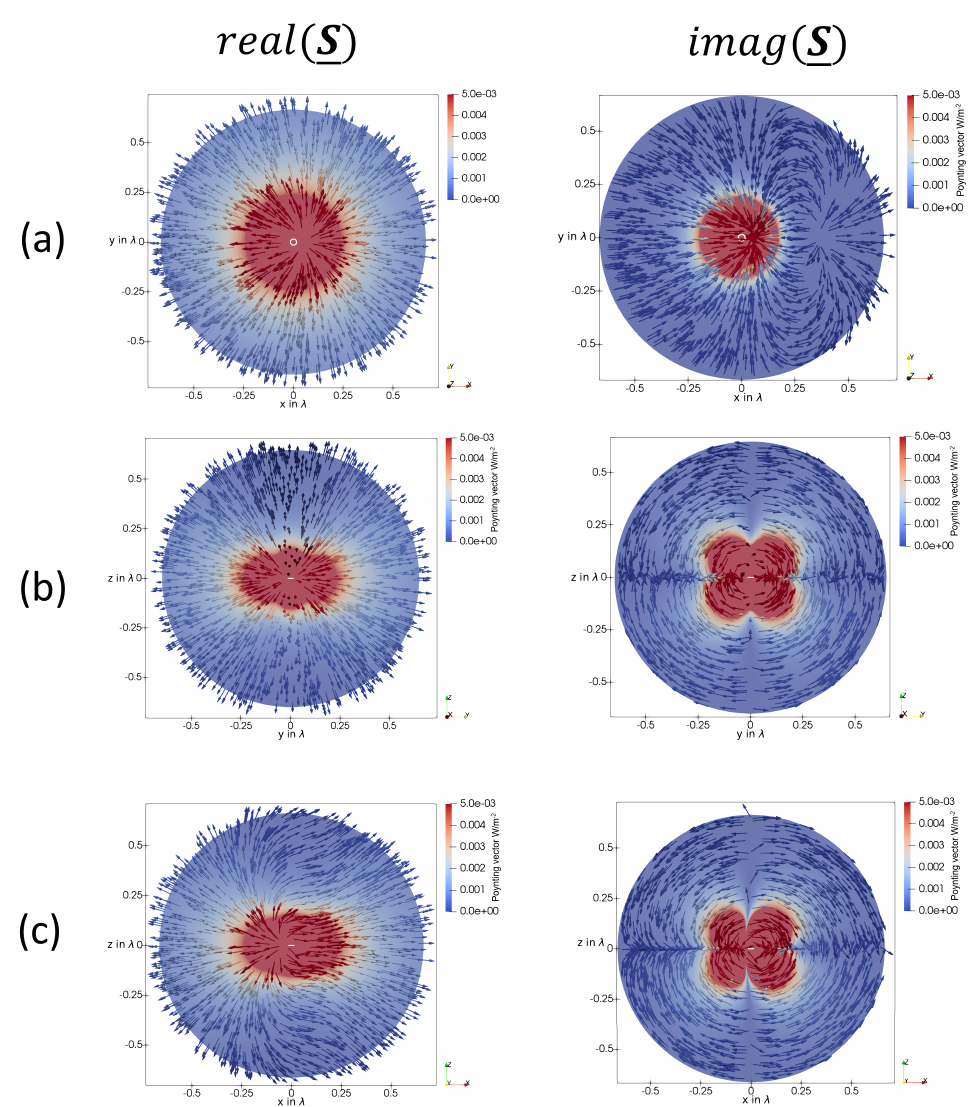
Figure 19. ( a ) The real and imaginary part of the Poynting vector in the xy-plane of a loop antenna with an overall circumference of 0.1 λ . ( b ) The real and imaginary part of the Poynting vector in the yz-plane of a loop antenna with an overall circumference of 0.1 λ . ( c ) The real and imaginary part of the Poynting vector in the zx-plane of a loop antenna with an overall circumference of 0.1 λ . In each sub-figure, the loop antenna is indicated as a white